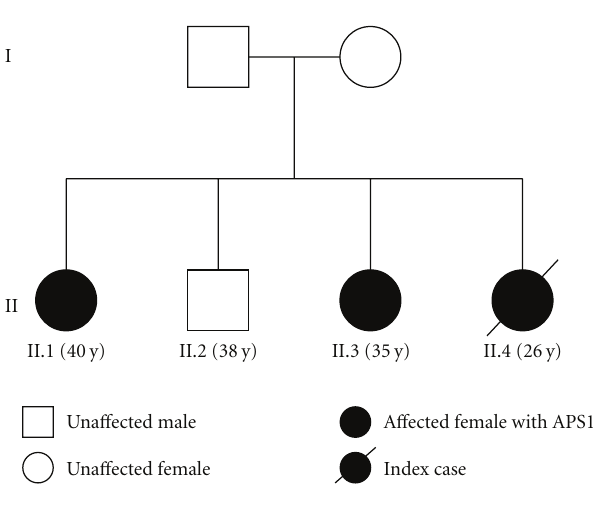
Figure 1: Pedigree.